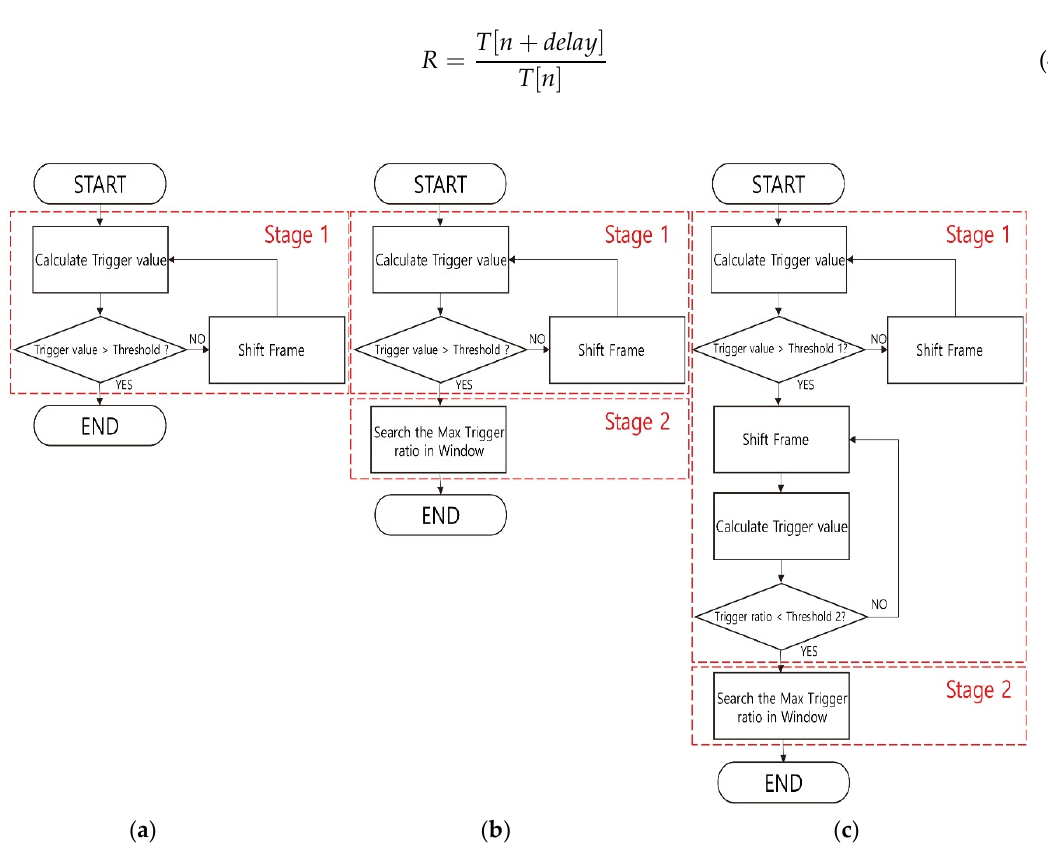
Figure 3. Flowchart of proposed methods. ( a ) conventional method; ( b ) proposed method 1; ( c ) proposed method 2. ( c ) proposed method